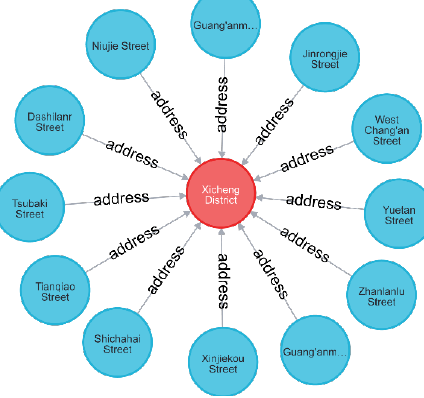
Figure 7 Results of querying ‘Historic Districts in Beijing Xicheng District’ with our UHBKG.